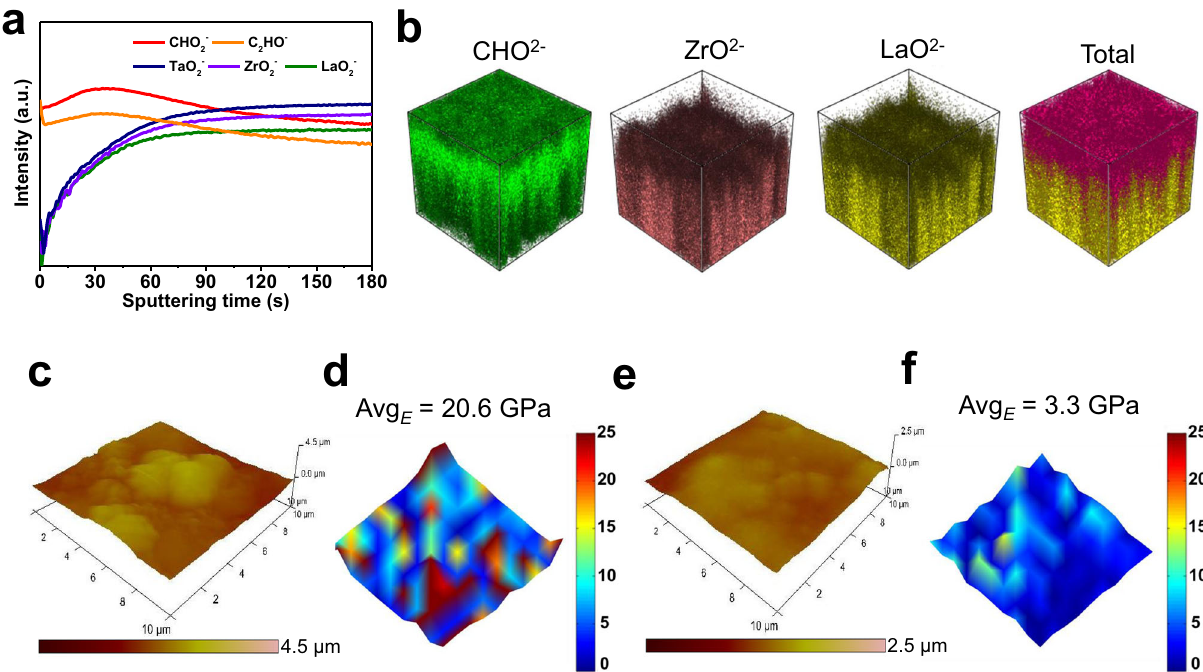
Fig. 1 Physical properties of the PAA layer on the surface of LLZTO. a TOF-SIMS depth pro fi les for the LLZTO@PAA pellet. b 3D views of the sputtered volume of LLZTO@PAA. c AFM topography image, and d Young ’ s modulus of LLZTO. e AFM topography image, and f Young ’ s modulus of